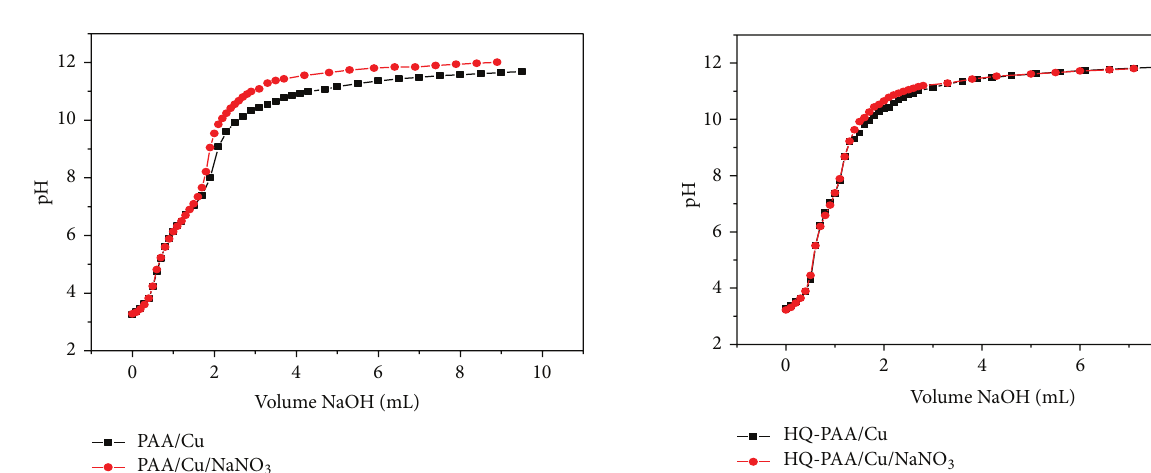
Figure 4: Plots of pH = f (𝑉 PAA/Cu(II)/NaNO 3